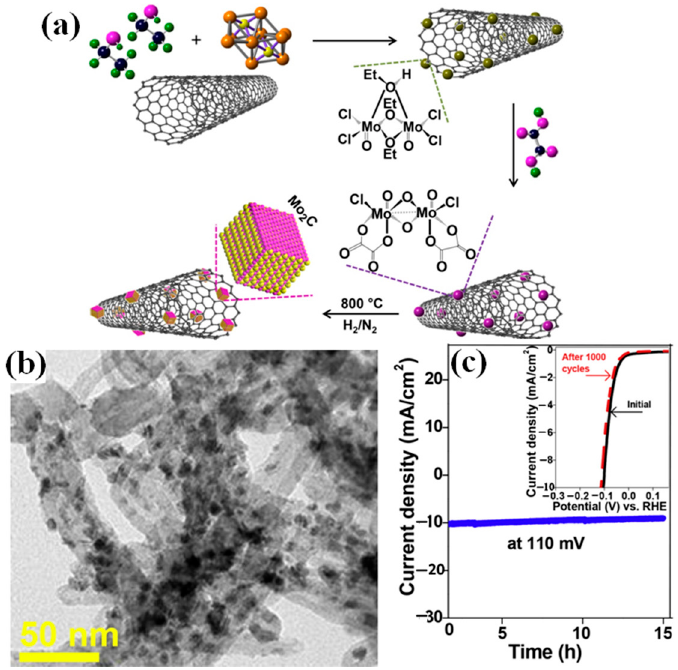
Figure 1. ( a ) Growth mechanism of Mo 2 C on CNTs surface. ( b ) TEM images of oxalate derived Mo 2 C/CNTs. ( c ) Time dependent profile of current density achieved under a constant 110 mV overpotential, with the inset figure of the polarization curves initially recorded and after 1000 cycles. Reproduced with permission from [81]. Copyright 2019, Elsevier.